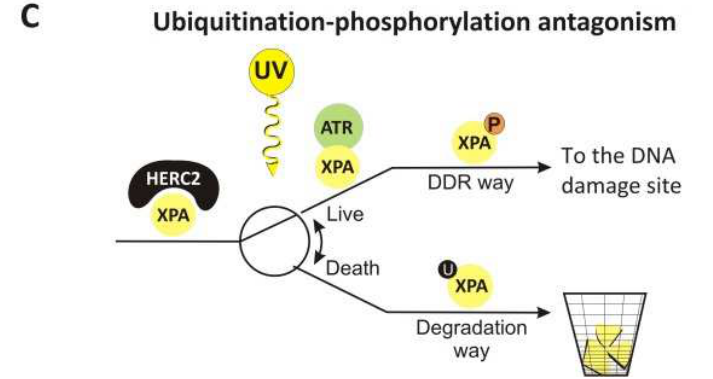
Figure 5. The circadian rhythm of XPA’s life. ( A ) The circadian rhythm of NER activity is due to the circadian oscillation of XPA mRNA and the protein levels. In a mouse model, it was shown for the brain, skin, and liver that the elimination of cisplatin–DNA adducts by the NER system exhibits a robust circadian rhythm, with the zenith in the late afternoon hours (~5 p.m.) and the nadir in the early morning hours (~5 a.m.). This oscillation is caused by the circadian rhythmicity of Xpa transcription and translation. ( B ) The balance between production and degradation. The mammalian circadian clock is generated by a transcriptional–translational feedback loop: core clock proteins CLOCK and BMAL1 activate the transcription of many clock-controlled genes, including repressor genes period ( PER1/2 ) and cryptochrome ( CRY1/2 ), by binding to E-box elements in their promoters and activating their transcription. After a time delay, the CRY and PER proteins accumulate in the cytoplasm, then form the CRY–PER complex, and are translocated back into the nucleus to inhibit their own transcription, as well as the transcription of clock-controlled output genes, through the inhibition of CLOCK–BMAL1 activity. The amount of repressor proteins CRY and PER is also regulated by secondary feedback loops at the transcriptional level, as well as by proteolytic degradation [126]. Accordingly, the XPA mRNA and protein levels are regulated positively by the CLOCK–BMAL1 complex and negatively by the CRY–PER complex. To attain a sufficient amplitude of the XPA protein oscillation level, circadian transcriptional regulation is coupled with the permanent prompt removal of the XPA protein by ubiquitin-dependent degradation. ( C ) UV light-induced damage and protective phosphorylation. In response to UV in a dose-dependent manner, ATR binds to and phosphorylates XPA. The XPA–ATR interaction facilitates HERC2 dissociation from the XPA complex, resulting in the accumulation of XPA